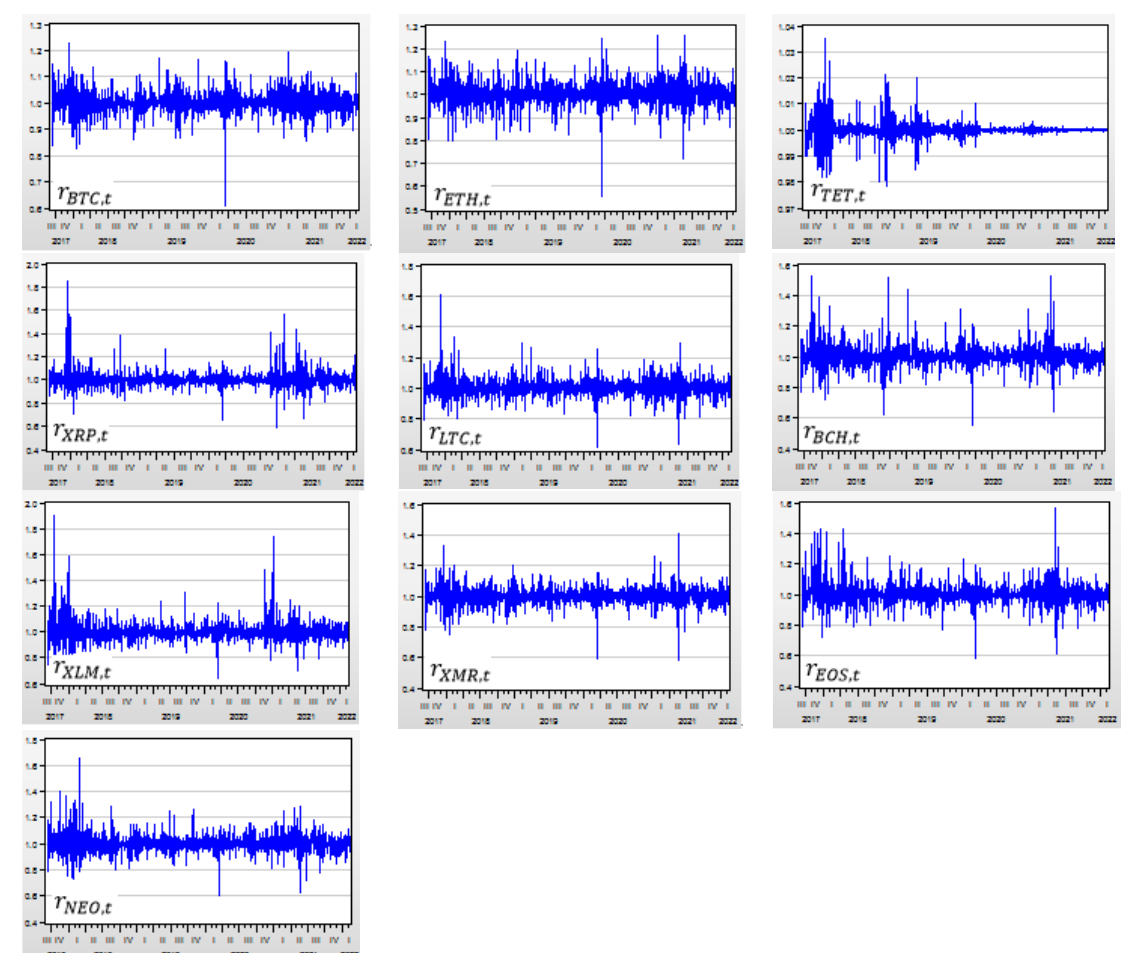
Figure 1. Curves of the return index for each of the 10 cryptocurrencies for the full period (8 September 2017–14 February